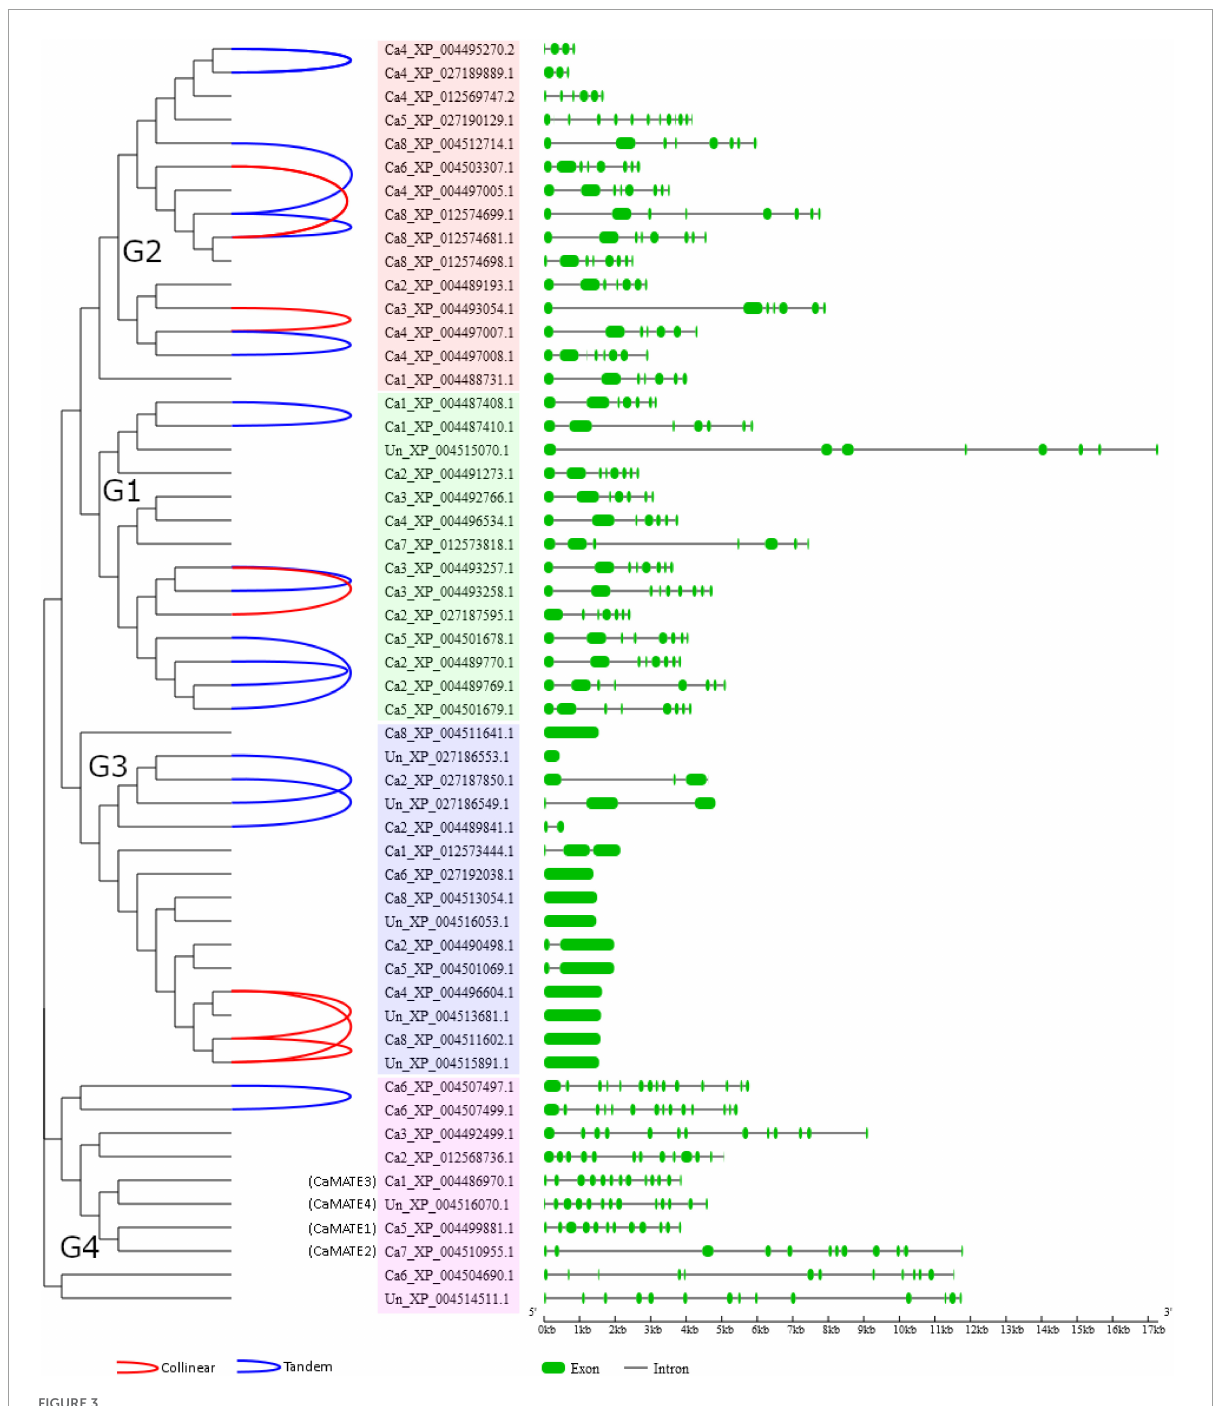
FIGURE3 Synteny and gene structural analyses of chickpea MATE family. The synteny and gene structural features were displayed based on the developed MATE phylogeny. On the left, identified collinear and tandem duplication gene pairs were linked by red and blue lines, respectively. In the middle, phylogeny groups G1-G4 were highlighted in pink, blue, light green, and red, respectively. On the right, exon and intron features were displayed in green rectangle and black line,